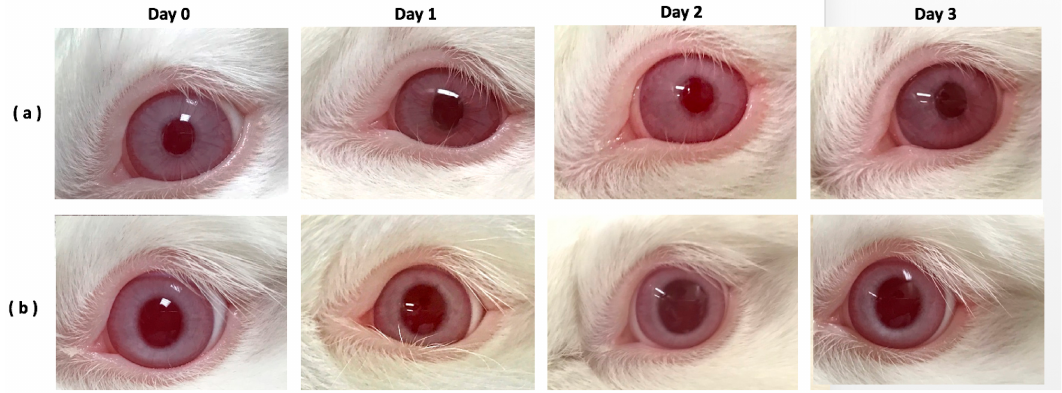
Figure 4. The appearance of rabbit eyes treated with 50 µL of ( a ) BS ( n = 3) and ( b ) BS with FA100/KM1 ( n = 8) addition using topical delivery as eye drops acquired on day 1 to day 3.